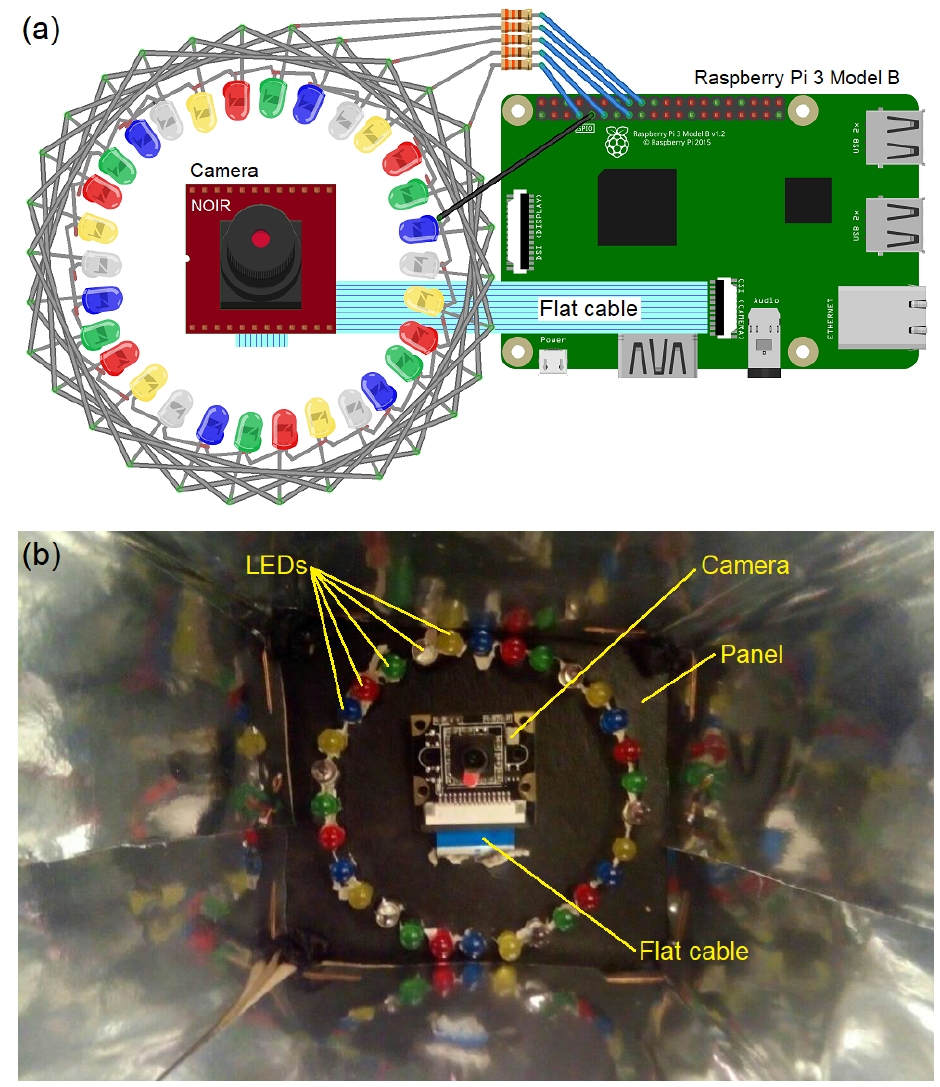
Figure 2. LED system and micro-camera disposition scheme ( a ) and photograph ( b